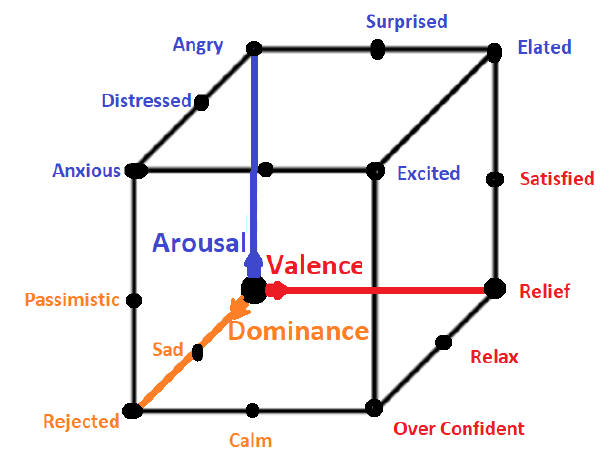
Figure 3. 2D Valence-arousal Model.